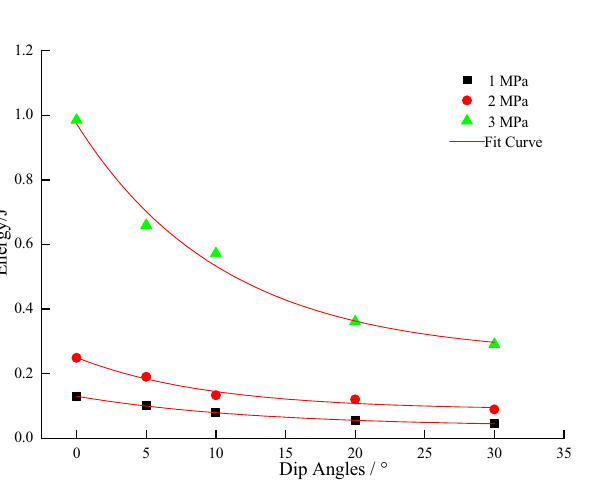
Figure 10. Fracture energy increment of post-peak rocks as a function of dip angle.